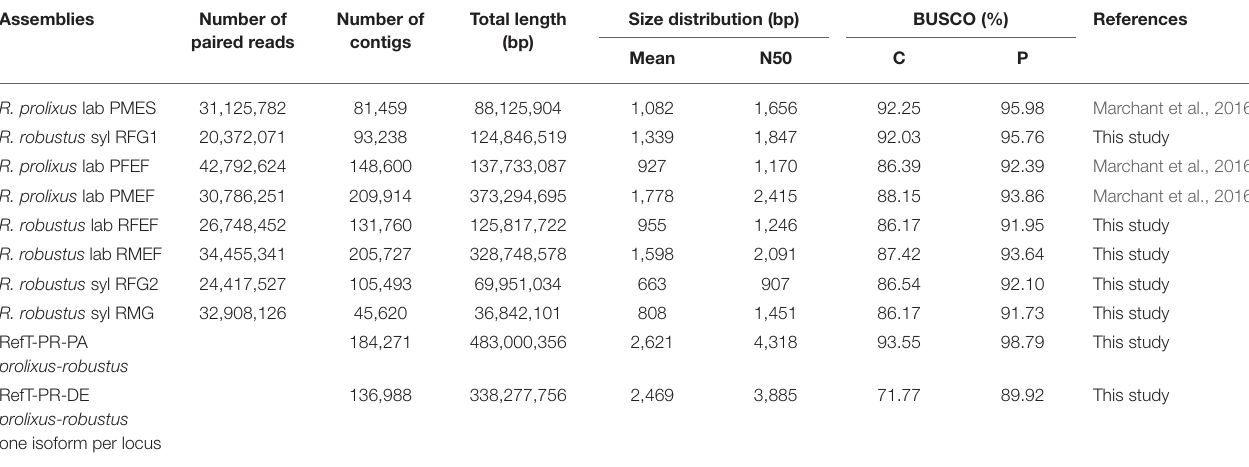
TABLE 2 | Summary of individual and merged transcriptome